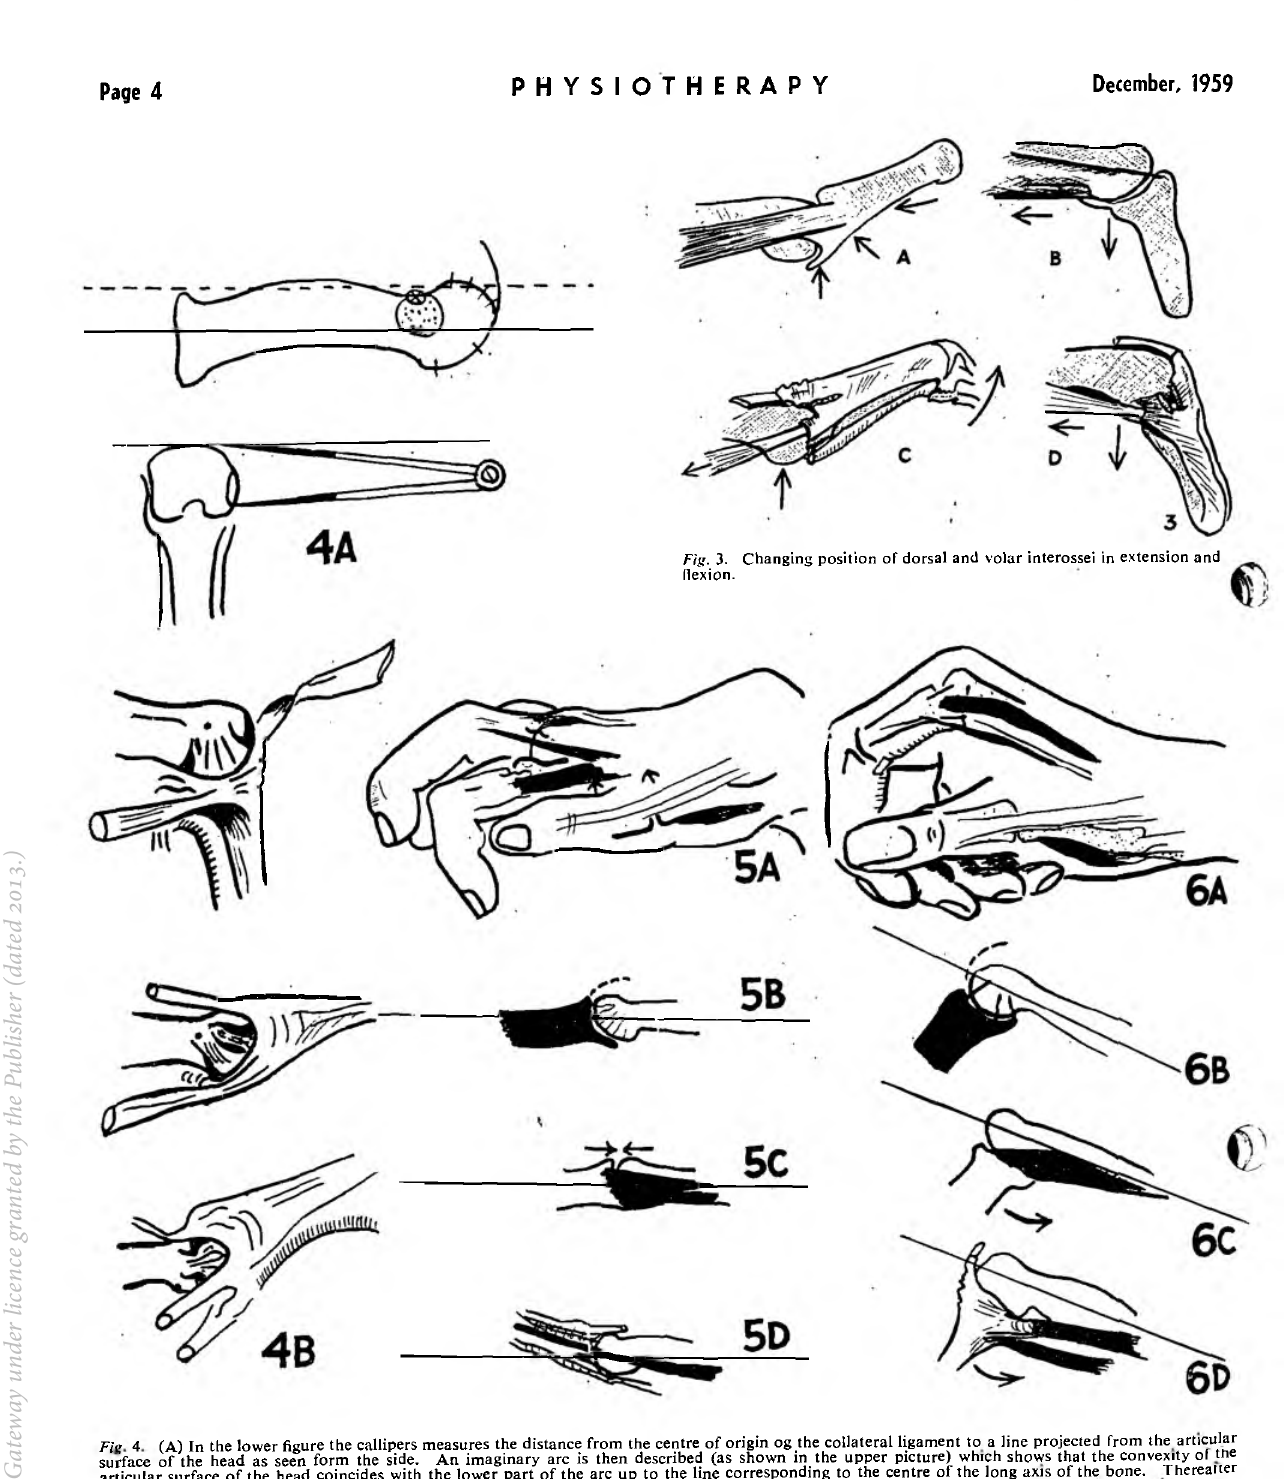
Fin 4 (A) In the lower figure the callipers measures the distance from the centre of origin og the collateral ligament to a line projected from the articular surface of the head as seen form the side. An imaginary arc is then described (as shown in the upper picture) which shows that the convexity ol tne articular surface of the head coincides with the lower part of the arc up to the line corresponding to the centre of the long axis of the bone. Therealter the line of the articular surface falls away within the arc, thus explaining why the collateral ligaments are taut on flexion and relaxed in extension. (B) Collateral ligaments of MP joint in 3 positions. Fig. 5. (A) Fixed claw hand. (B) Relaxation of dorsal fibres of collateral ligament in extension of MP joint. (C) Dorsal interosseous muscle pulling joint surfaces together in extension. (D) Volar interosseous muscle hyperextending (and adducting) the MP joint. Fig. 6. (A) Hand in position of function. (B) Collateral ligament taut in flexion of MP joint. , _ (C) Dorsal .interosseous muscle in position of mechanical advantage (in flexion of MP joint). (D) Volar interosseous muscle (and lumbrical). Note changed function of volar interosseous muscle in